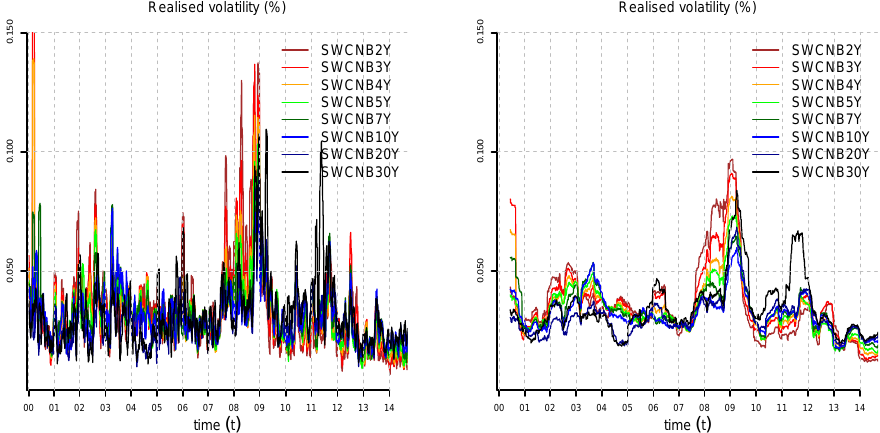
(cid:92) RCov ( t , τ , τ ) 1 2 for τ /252 = 2,3,4,5,7,10,20,30, window length